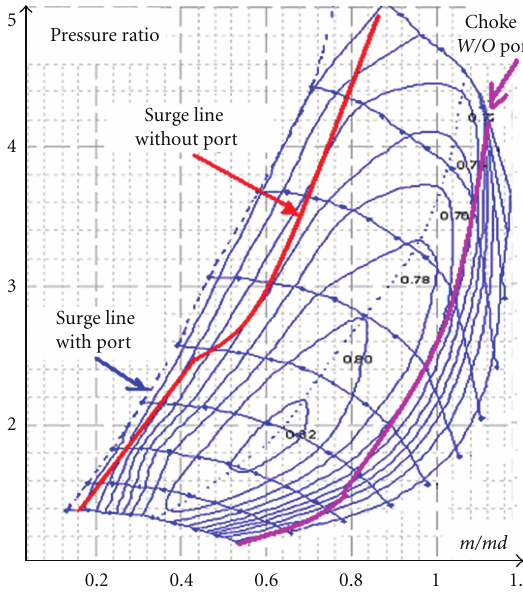
Figure 32: Ported shroud compressor